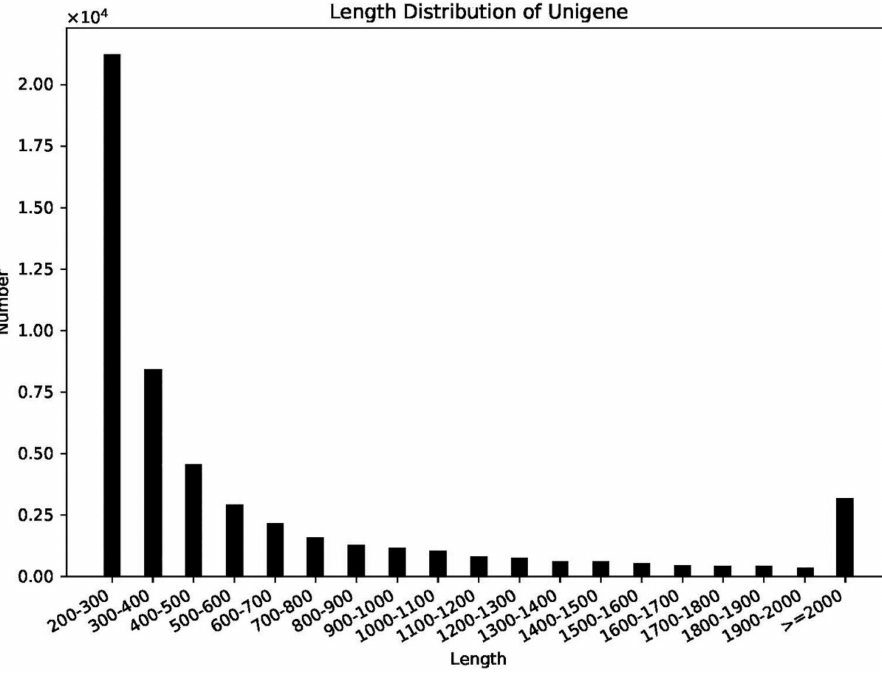
Figure 2. Length distribution of assembled unigenes. Table 1. Numbers of transcripts annotated in seven